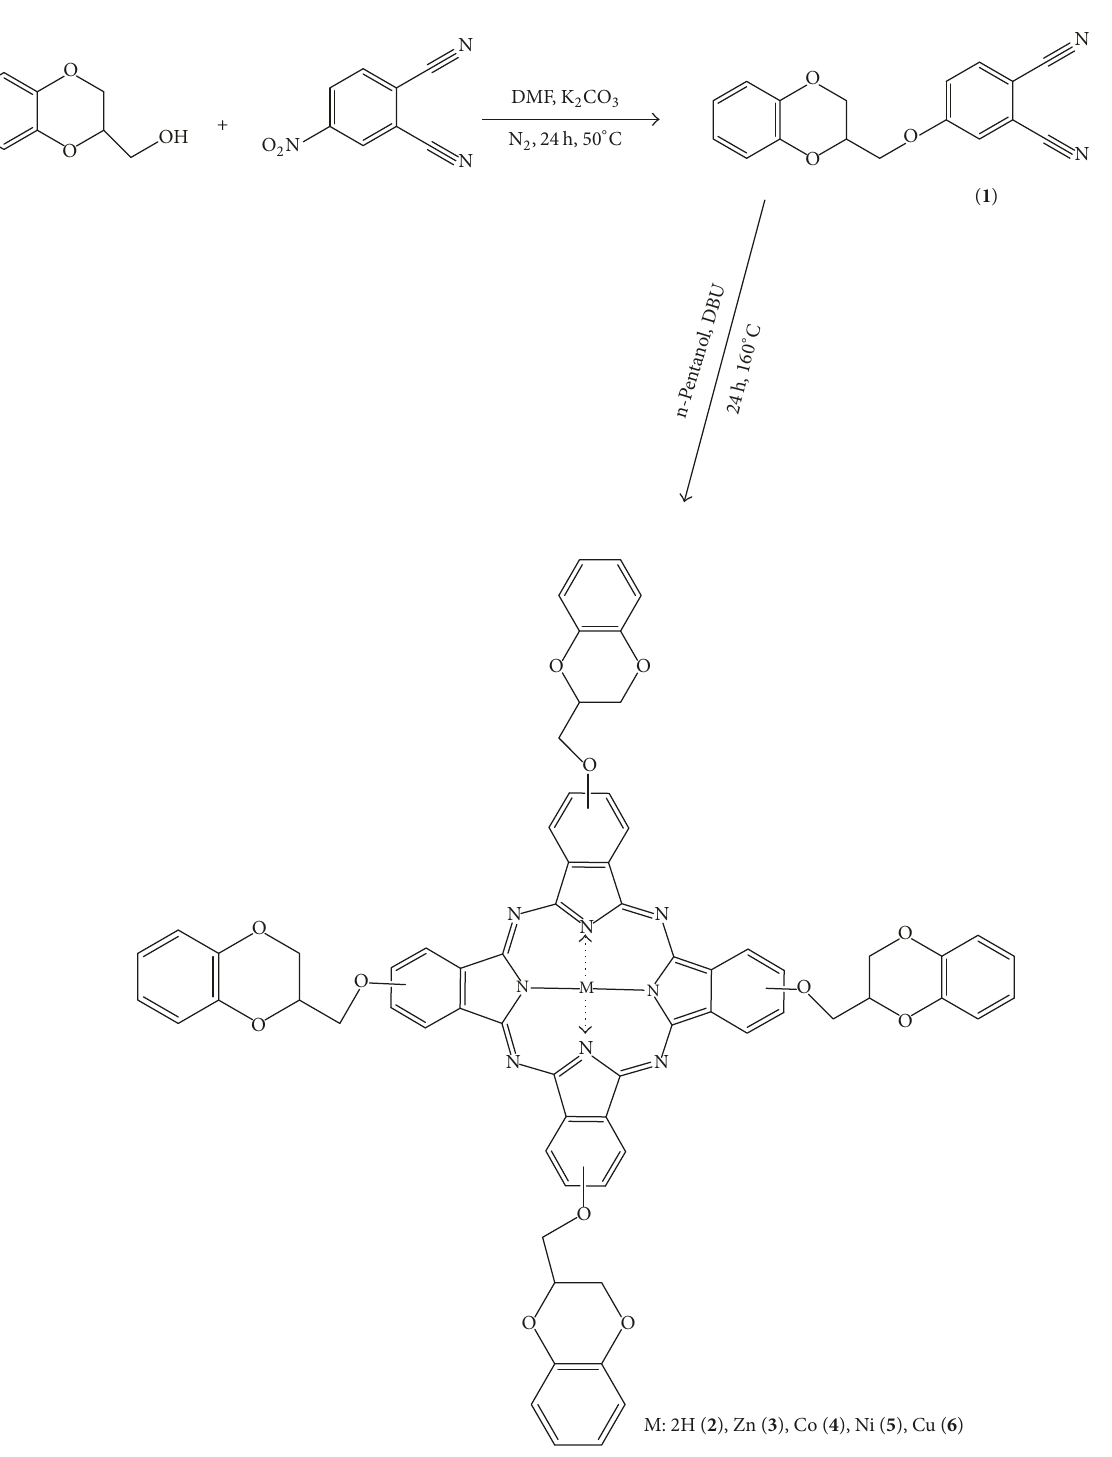
Scheme 1: Schematic representation of synthesized compounds ( 1–6